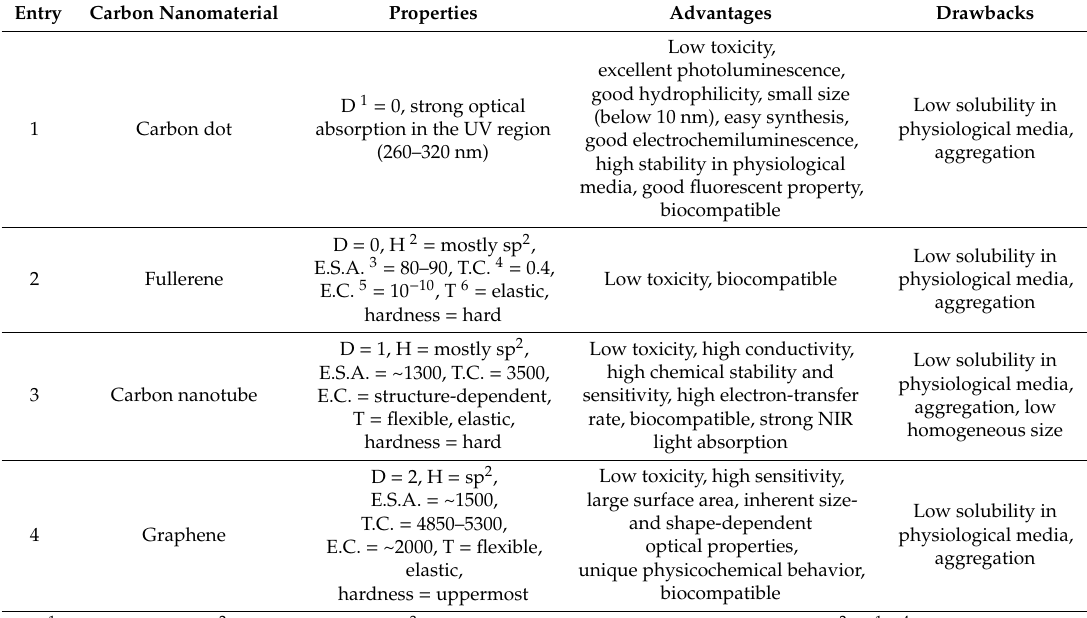
Table 1. General properties, advantages, and drawbacks of some carbon nanomaterials [83–85].